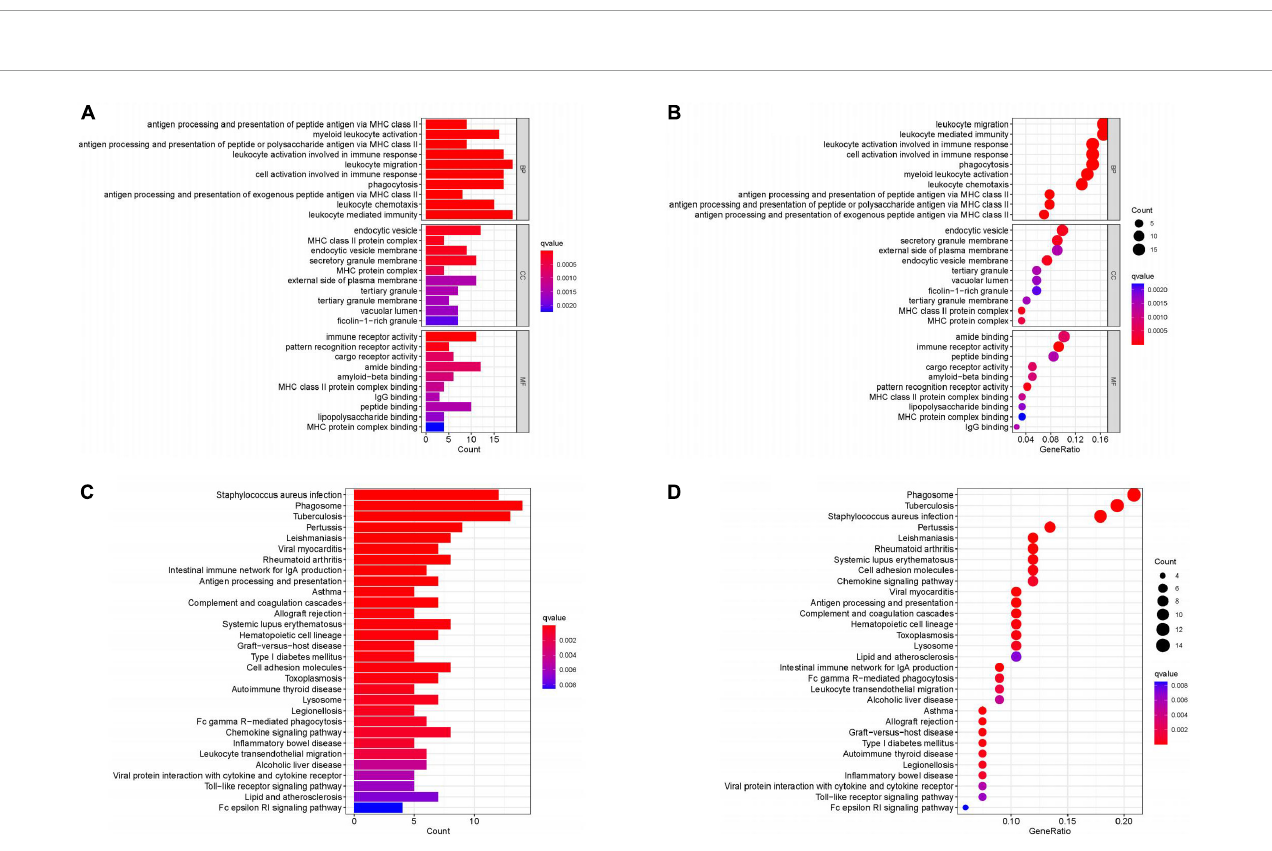
FIGURE4 Enrichment analysis. (A,B) GO enrichment analysis. (C,D) KEGG enrichment analysis. (Histogram, the darker the color of the bar the more significant the enrichment. Bubble plot, the larger the bubble the darker the color the more significant the